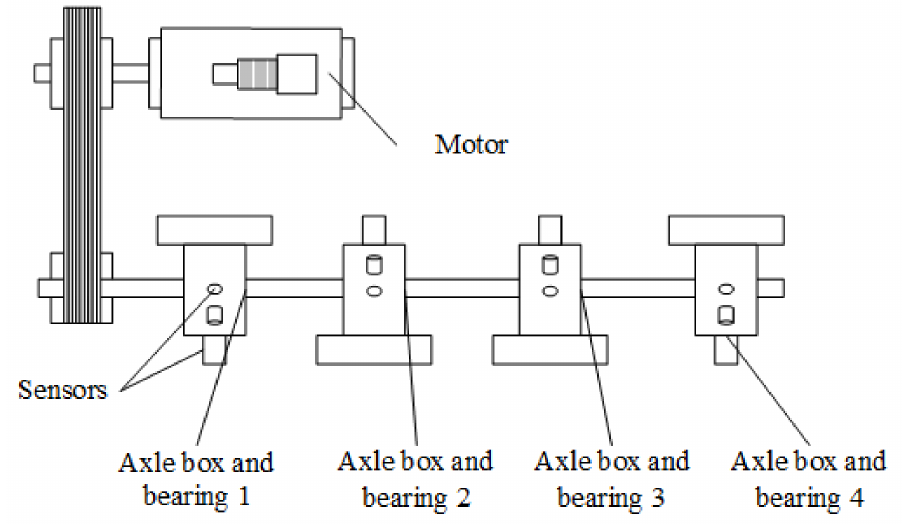
Figure 2. Schematic diagram of the test